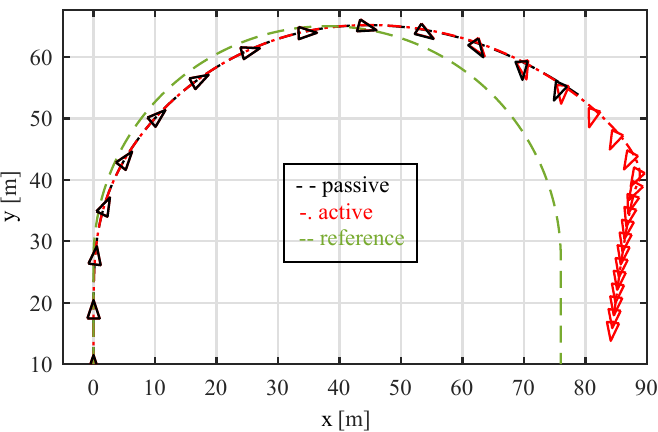
Figure 15. U-turn, µ jump, highly skilled driver, vehicle cog trajectory. Triangles represent the orientation of the vehicle x -axis starting from the vehicle